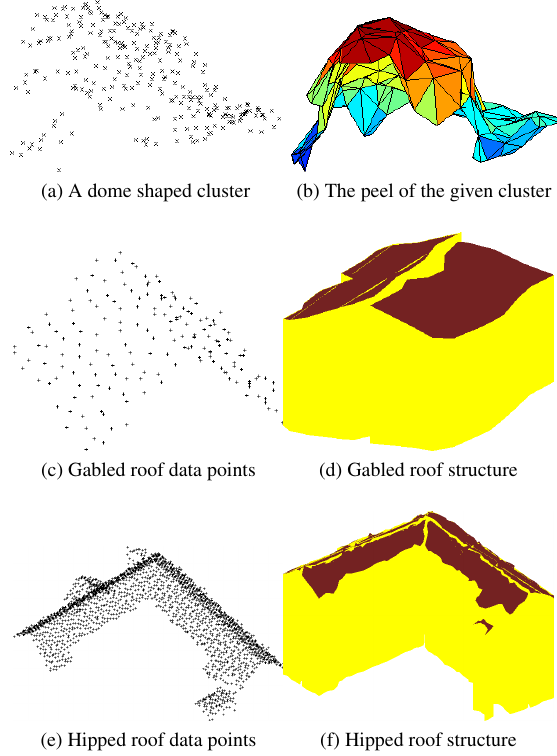
Figure 6: (a) A dome shaped cluster (b) A “peel”ed dome cluster using tetrahedralization and subsequent thresholding of the trian- gular facets. The colors of the triangles vary from dark blue to dark red based on the elevation of the centroid of the triangles (c) Data points for a gabled roof (d) The gabled roof structure gen- erated by the pipeline (e) Data points for a hipped roof (f) The hipped roof structure generated by the pipeline.